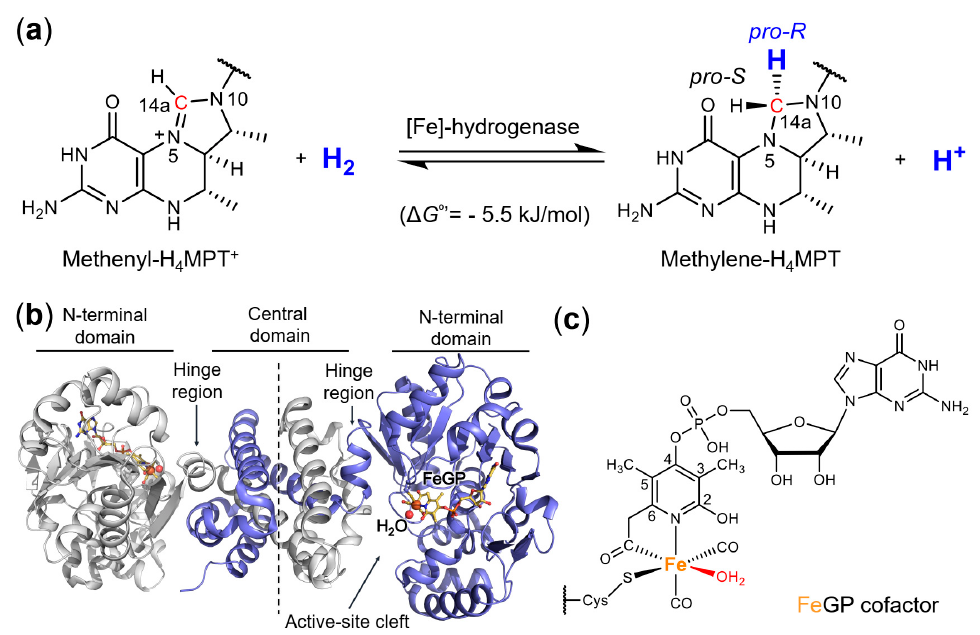
Figure 1. Structure and function of [Fe]-hydrogenase. ( a ) Reaction catalyzed by [Fe]-hydrogenase. The side chain of H 4 MPT was omitted. ( b ) Crystal structure of [Fe]-hydrogenase (holoenzyme) from Methanococcus aeolicus (PDB: 6HAC). Two monomers are shown as a cartoon model (grey and blue). The FeGP cofactor is depicted as a ball and stick model. A water molecule is bound to the iron in the open resting state. ( c ) Chemical structure of the FeGP cofactor. Cys176 thiolate is covalently bound to the iron of the cofactor.